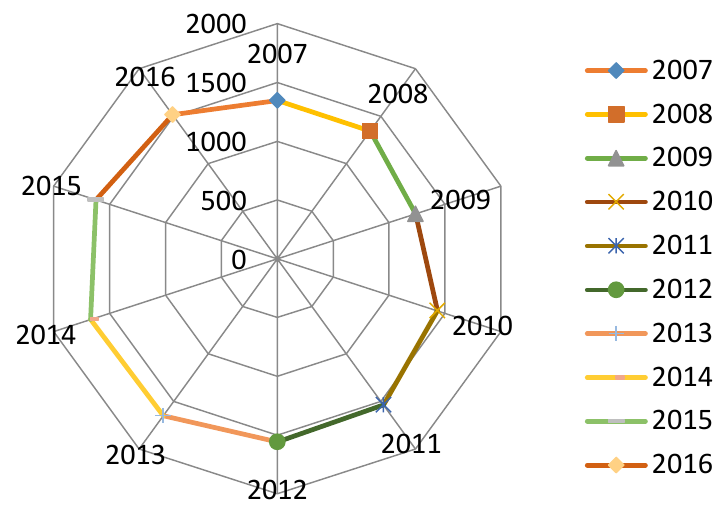
Figure 3. Dynamic tendencies of steel